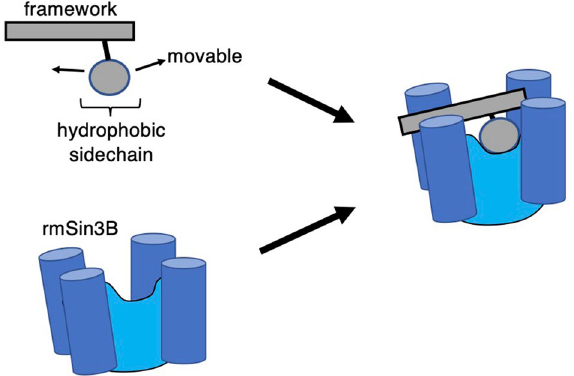
Figure 9. Scheme of a compound that binds to the cleft of